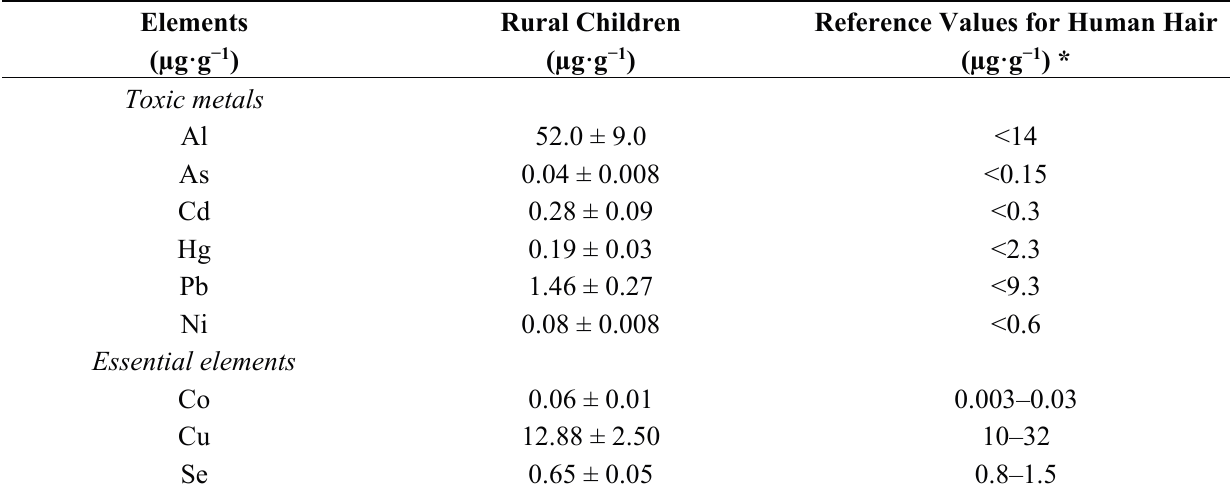
Table 3. Concentrations of toxic metals and essential trace elements in hair of rural children ( n =